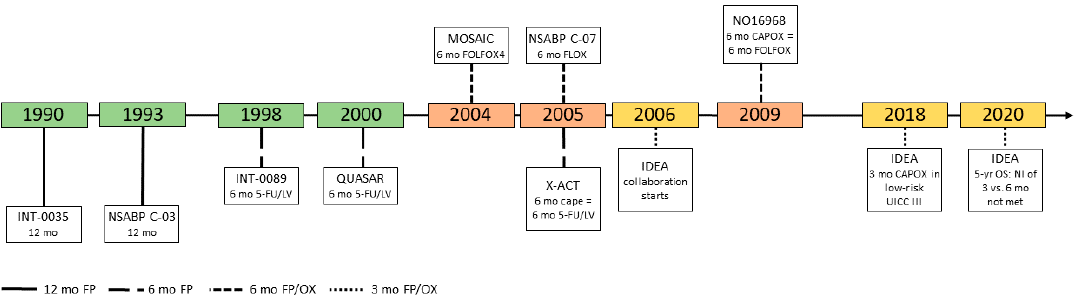
Figure 1. Years of adjuvant chemotherapy in colon cancer: from 5-FU (backbone) to FP / oxaliplatin (5-FU 5-fluorouracil, FP fluoropyrimidine, LV leucovorin, FOLFOX4 5-FU / LV + oxaliplatin, FLOX FULV + oxaliplatin, cape capecitabine, CAPOX capecitabine + oxaliplatin, NI non-inferiority, OX oxaliplatin) .